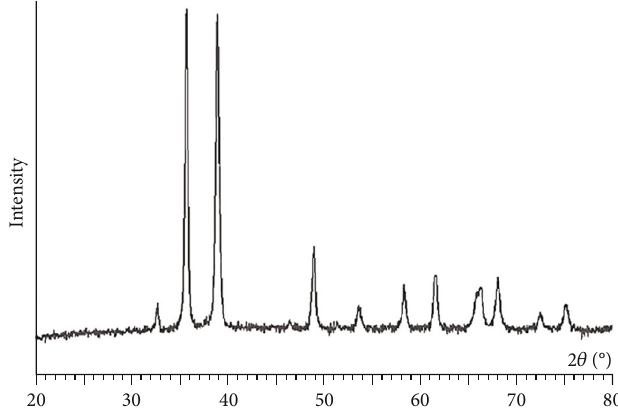
Figure 10: XRD pattern of CuO nanoparticles.